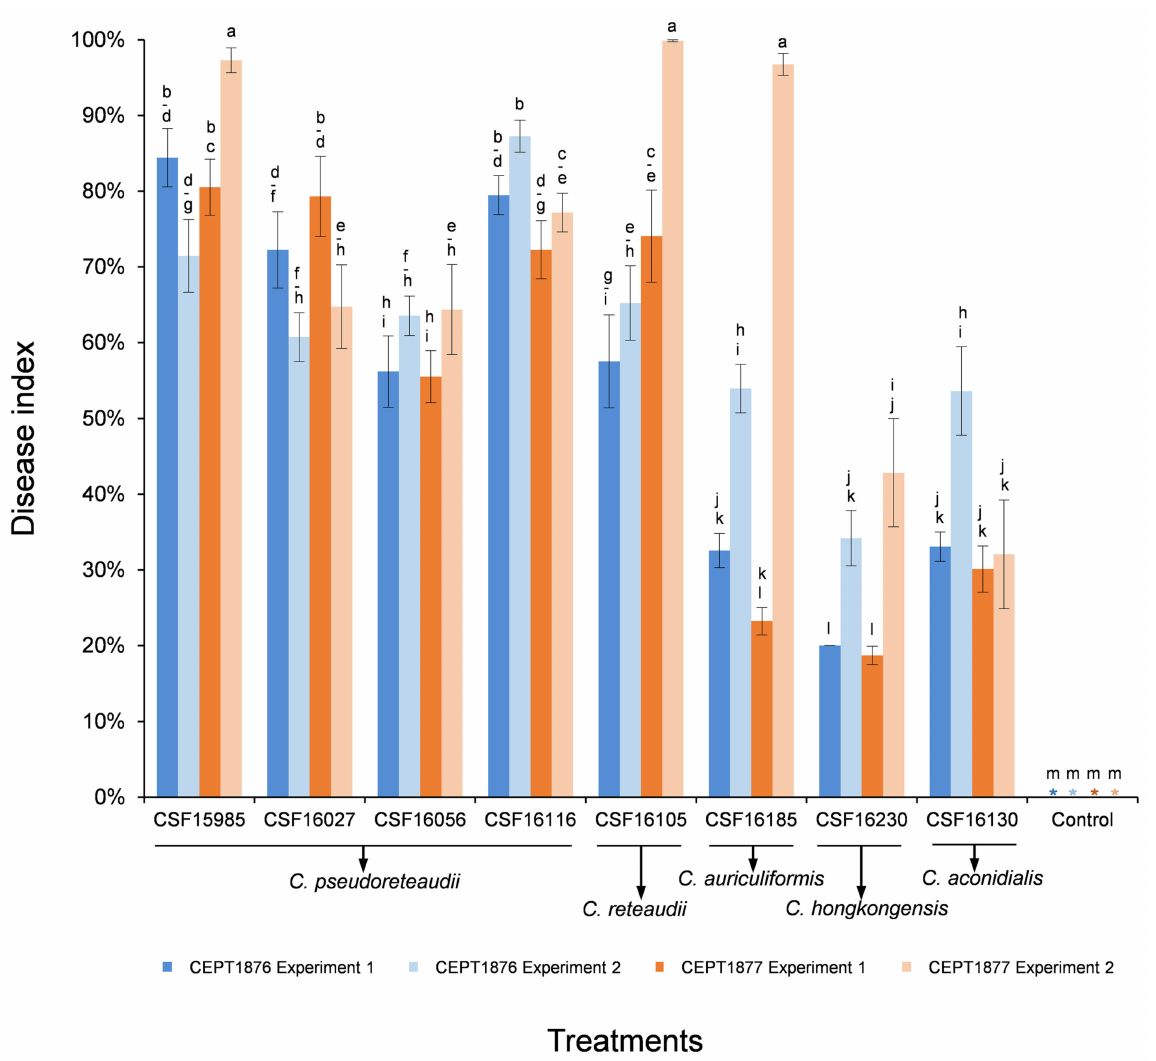
Figure 5. Column chart indicating the disease index (%) resulting from conidia suspension inoculation trials of two Eucalyptus hybrid genotypes inoculated with five Calonectria species and the controls, two experiments were conducted. Vertical bars represent standard error of means. Bars topped with different letters indicate that treatment means are significantly different ( p = 0.05). The “*” indicates that the disease indexes of negative controls are